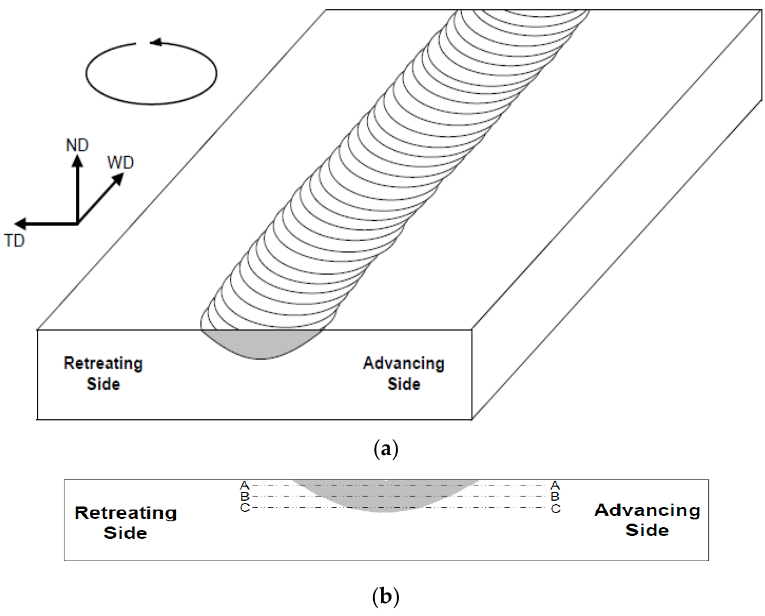
Figure 1. Schematic illustration of FSP: ( a ) geometry of the Al6063 plate with single pass showing the size of the processed zone and direction of tool rotation; ( b ) cross-section of the plate showing lines of measurements for microhardness.